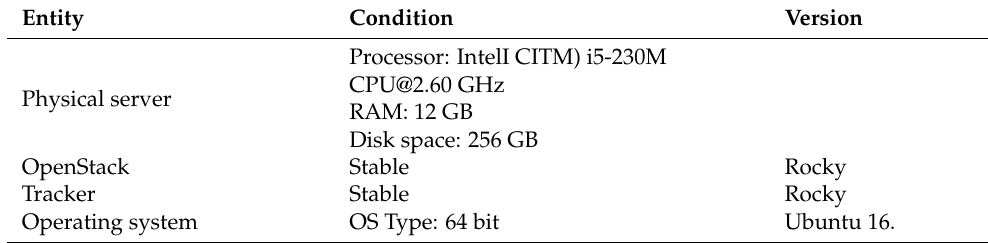
Table 1. Implementation specifications.